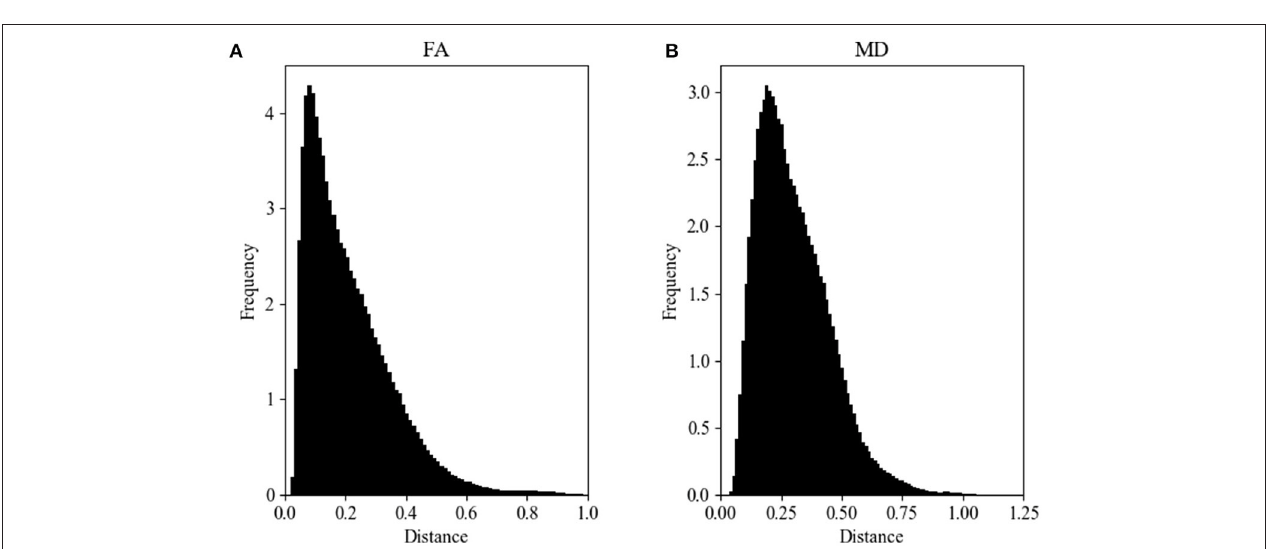
FIGURE 3 | FA (A) and MD (B) map Hellinger histogram distance metric for the within-group GE (all b -values, all gradient directions, all field strengths) (number of comparisons = 434,778).